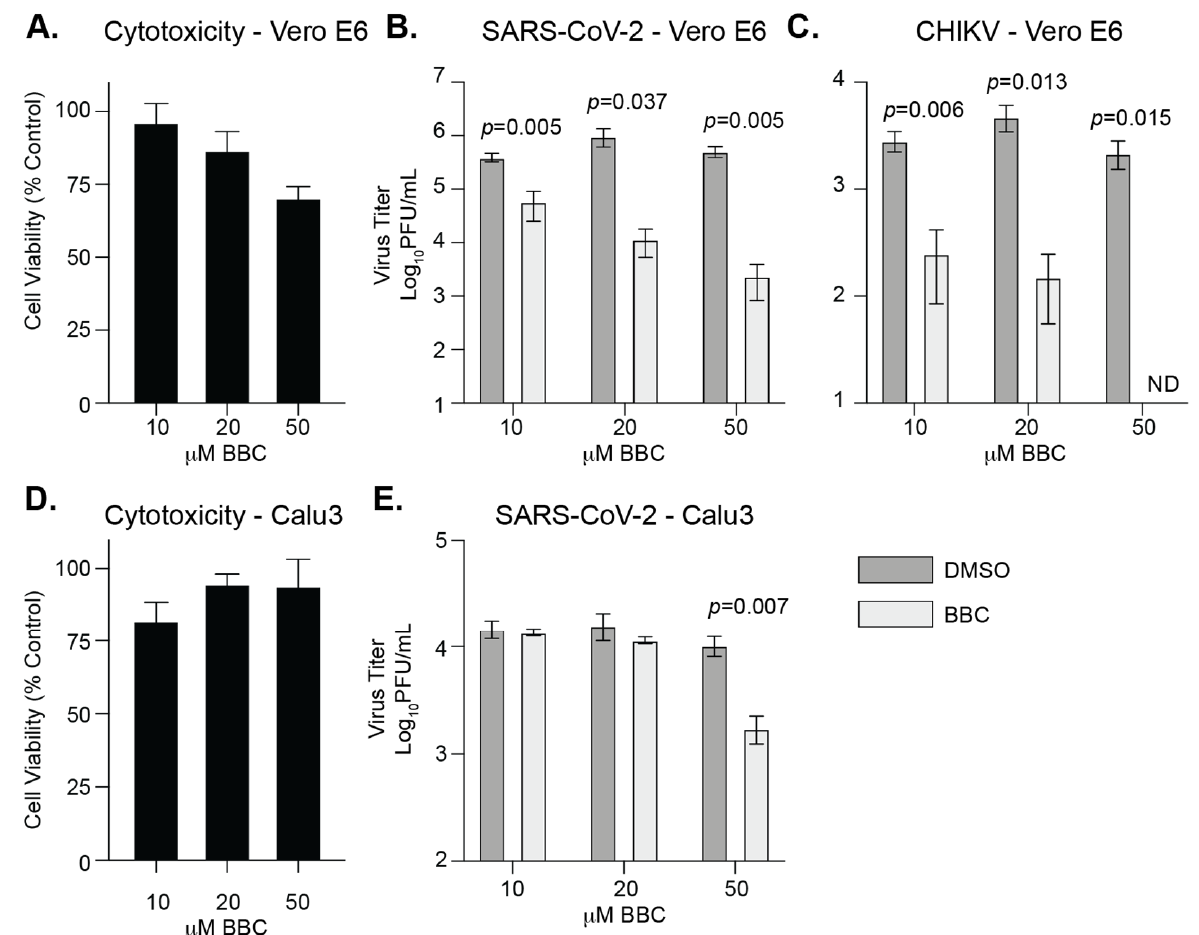
Figure 5. Berberine chloride inhibits SARS-CoV-2 replication in vitro. ( A ) Cytotoxicity of BBC in Vero E6 cells measured by MTT assay. N = 2 with internal triplicates. Vero E6 cells were infected with SARS-CoV-2 (MOI = 0.1) ( B ) or CHIKV (MOI = 1) ( C ) BBC or DMSO was added at 6 hpi and supernatants were harvested at 24 hpi. Viral titers were quantified by plaque assay. Data represent the mean and range of two independent experiments with internal duplicates. Students t -test. ( D ) Cytotoxicity of BBC in Calu3 cells measured by MTT assay. N = 2 with internal duplicates. ( E ) Calu3 cells were infected with SARS-CoV-2 (MOI = 0.1) and BBC was added at 6 hpi. Supernatants were harvested at 36 hpi. Viral titers were quantified by plaque assay. Data represent the mean and SEM. N = 3 with internal duplicates. Students t -test. ND = not detected (below limit of detection).